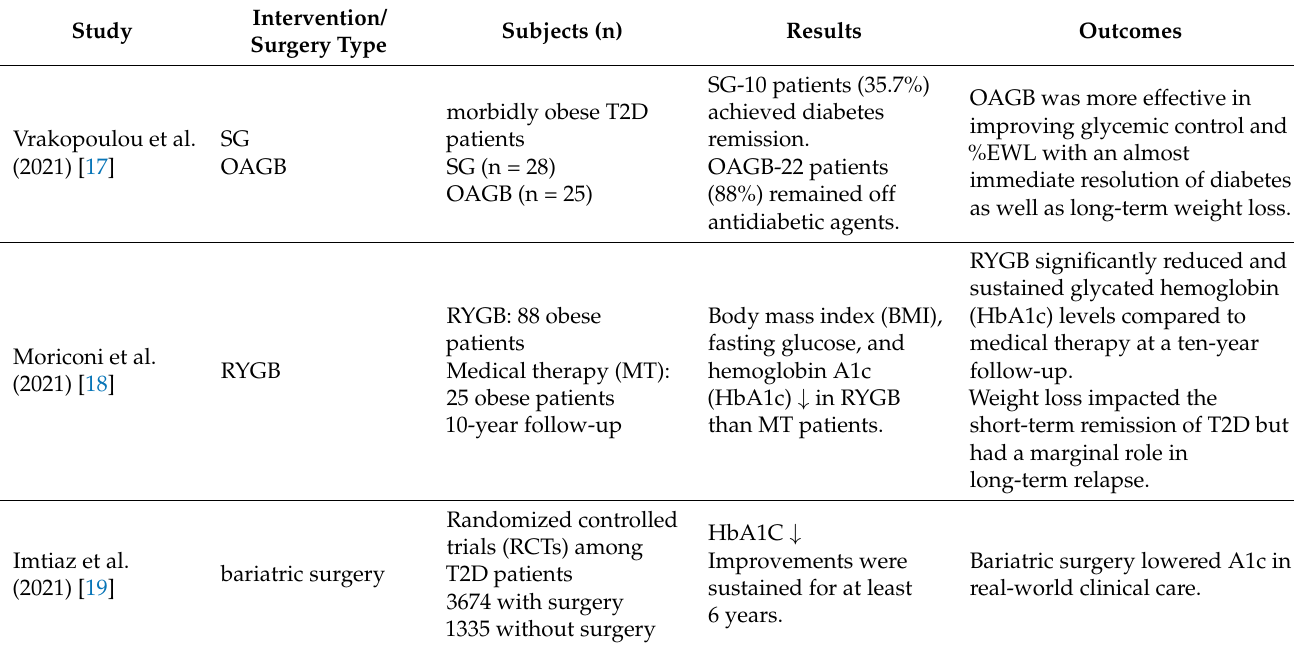
Table 1. Summary of studies assessing the impact of metabolic surgery on the control of